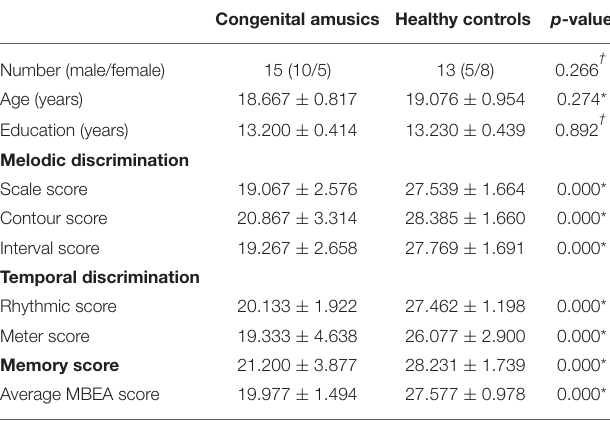
TABLE 2 | Characteristics of the congenital amusia and healthy control groups. Congenital amusics Healthy controls p